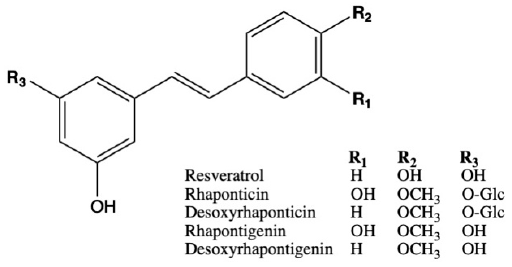
after termination of HRT (E 2 withdrawal).